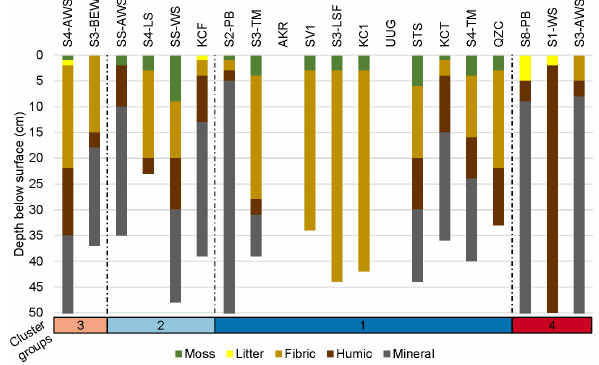
Figure 10. The profiles of soil layers in the active layer at each site, organized according to the cluster analysis are